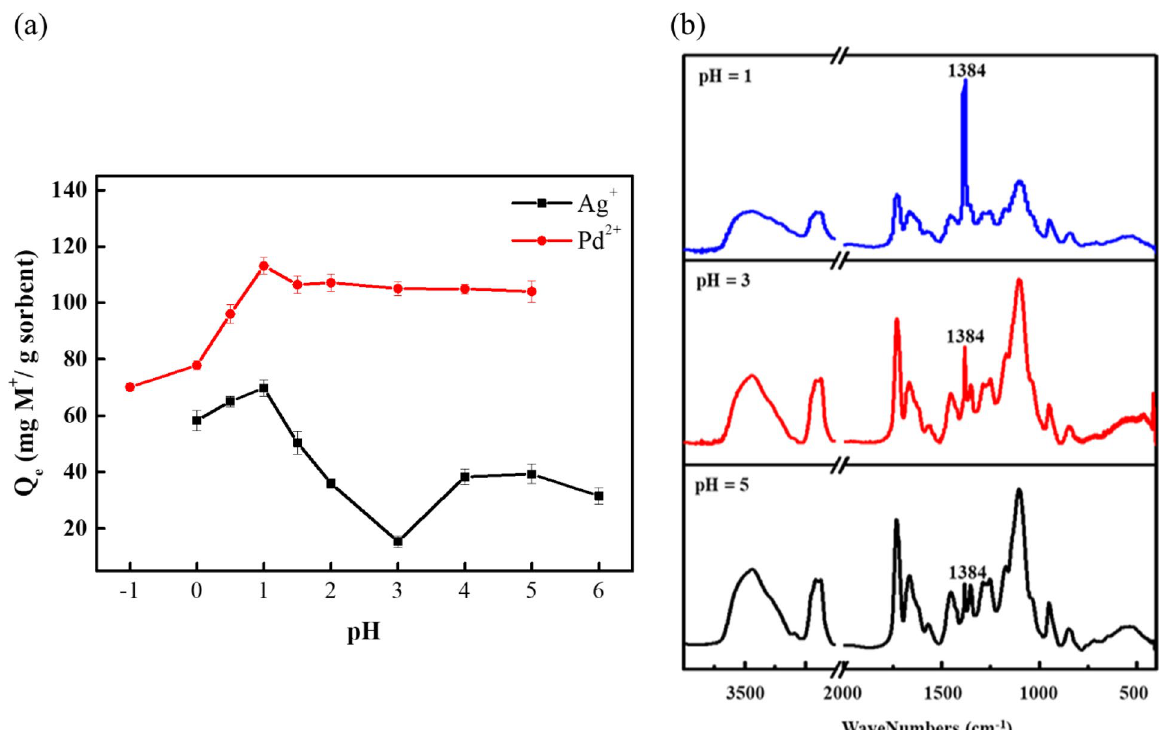
Figure 2. Effect of pH on adsorption capacity. ( a ) Adsorption capacity of ATU-PEGDA under different pH of the solution toward Ag(I) and Pd(II). ( b ) Differences in FT-IR spectra of PEGDA-ATU hydrogel after Ag + adsorption at different pH